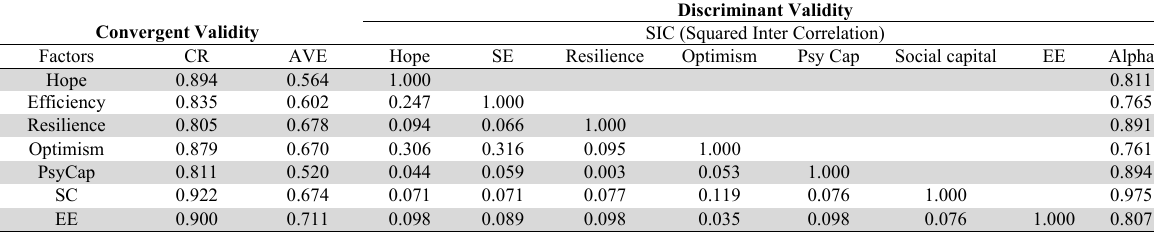
Convergent and Discriminant validities Convergent